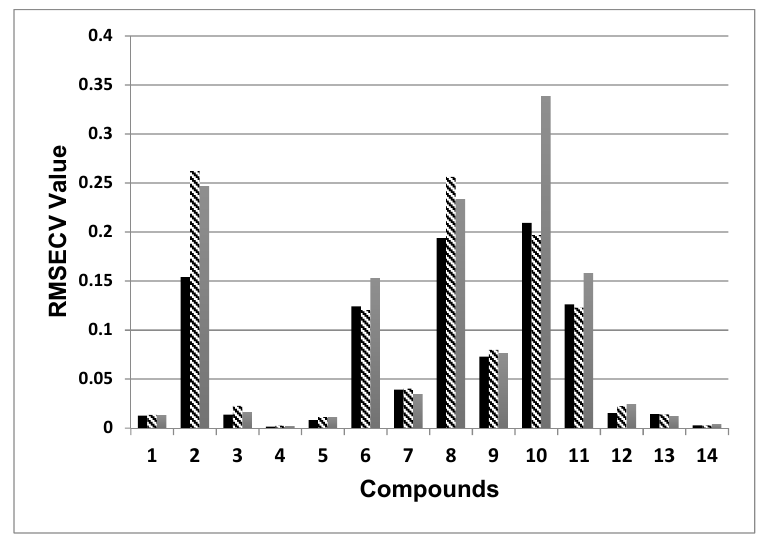
Figure 6. Comparison of the RMSECV values (numbering corresponds to the data from Table 4) obtained from the different methods of spectral data processing: zero order curve—grey box; first derivative with GS method—striped box; first derivative with SBSF—black box. RMSECV—root mean square error of cross-validation.